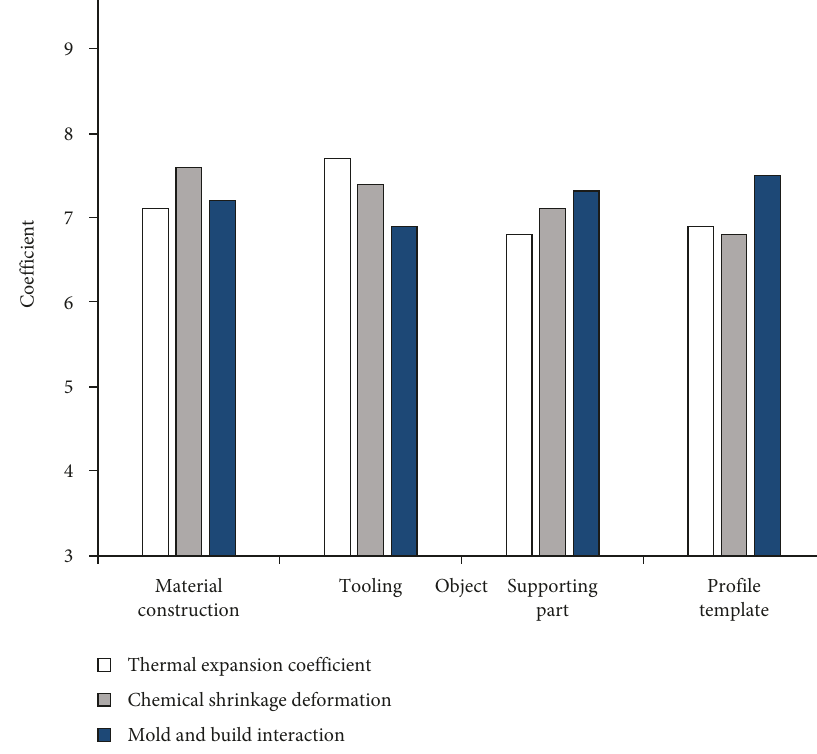
Figure 6: Deformation of ferroelectric materials.